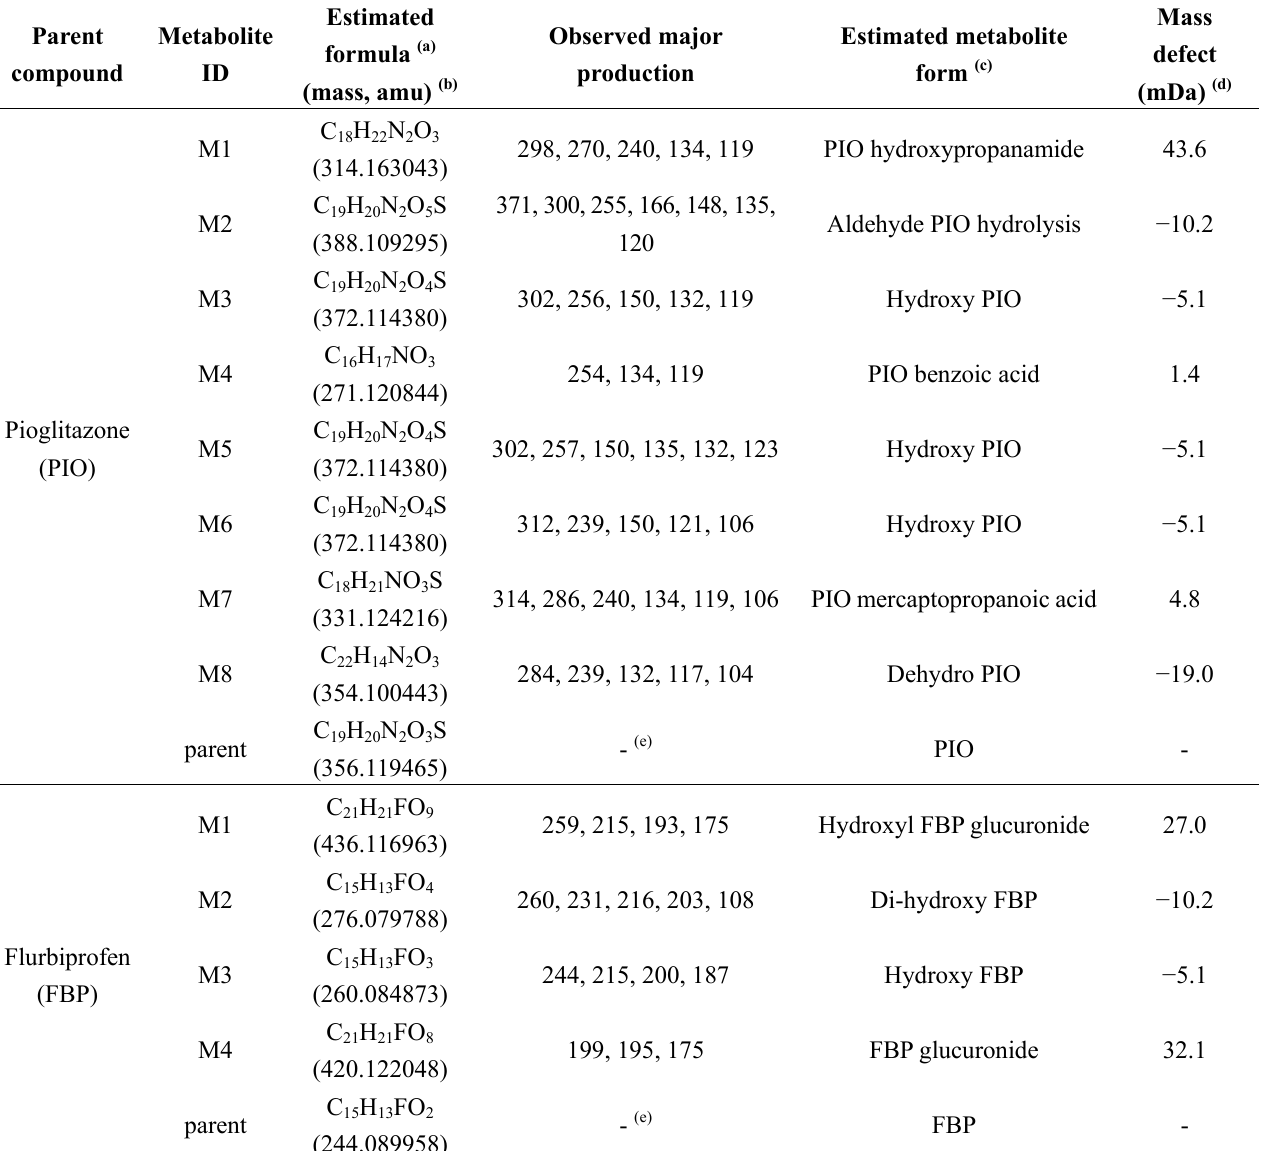
Table 3. Estimated in vitro human metabolites of pioglitazone and flurbiprofen using stable isotope mass-shift